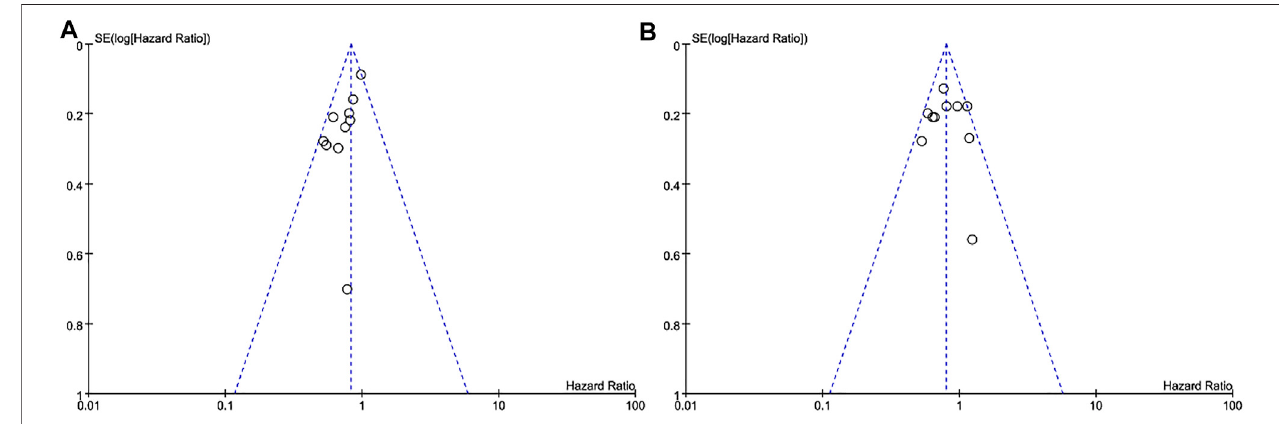
FIGURE 8 | Funnel chart of publication bias. (A) DFS. (B)